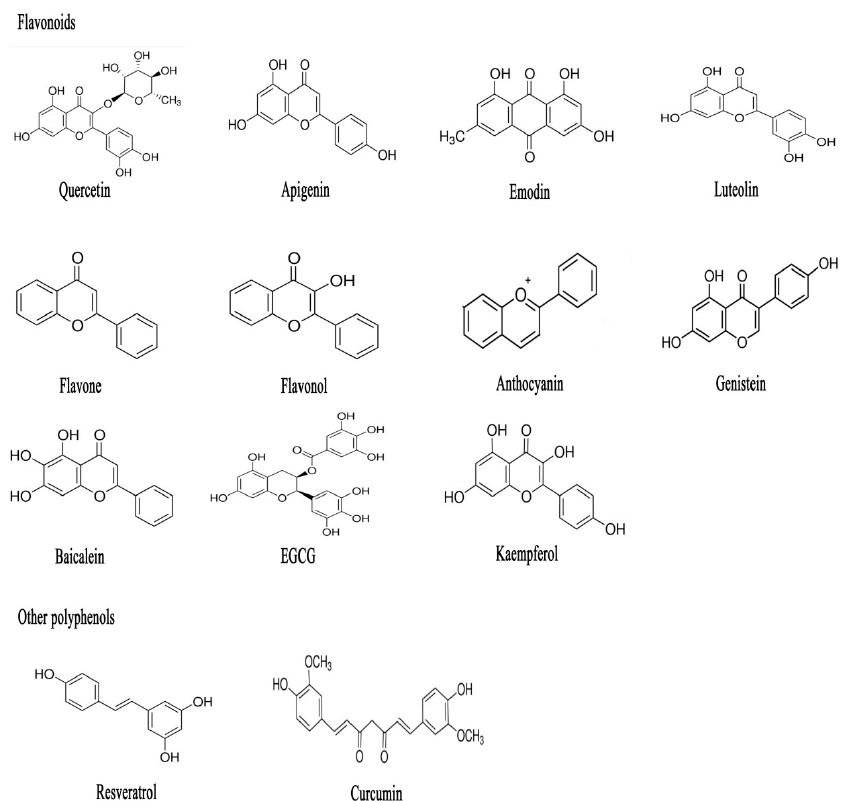
Figure 1. Chemical structure of some of the flavonoids and other polyphenolic compounds featured in this review. Polyphenols can be classified into flavonoids and tannins, alkaloids, terpenoids, and phenylpropanoid. Substantial variation is intuitively observed by distinct chemical substitutions, especially hydroxylation and glycosylation.